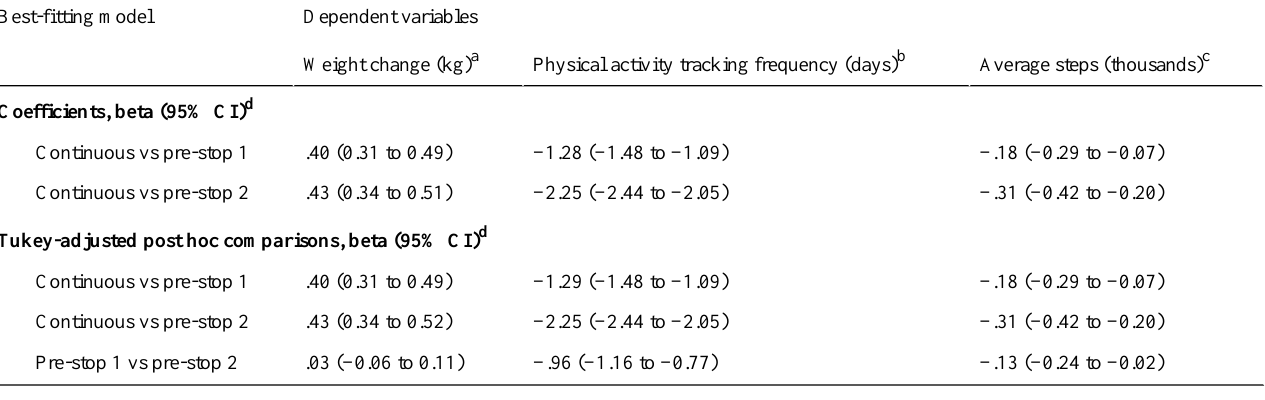
Table 1. Best-fitting models for the three dependent variables in the post hoc analyses.